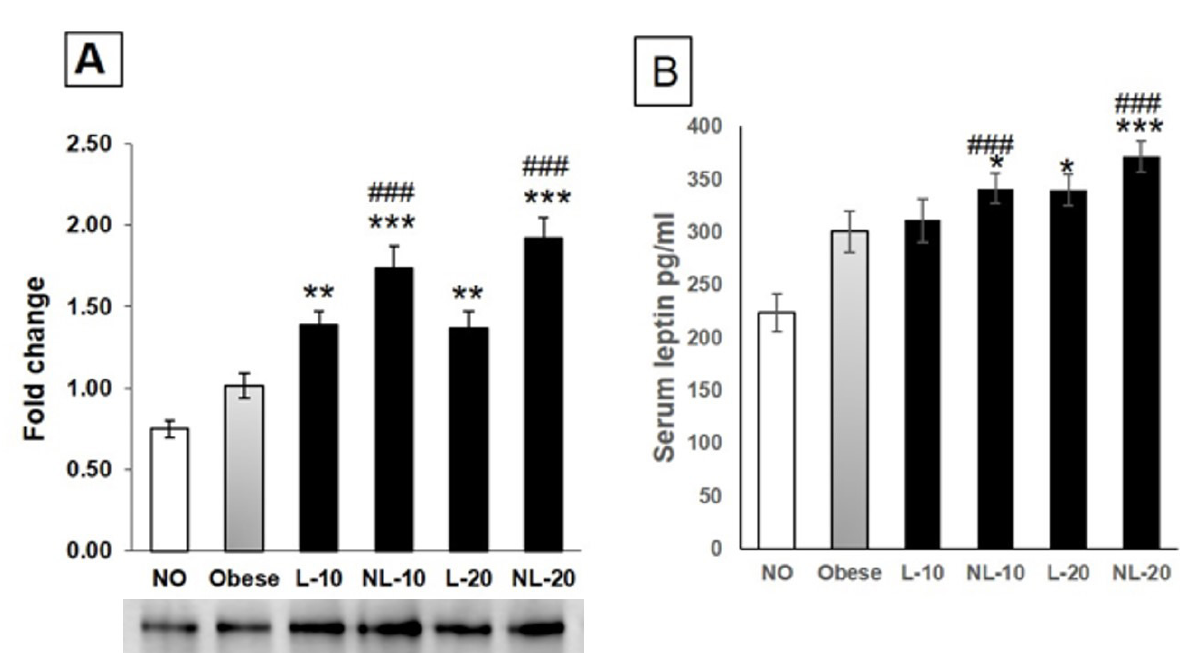
FIGURE 2- Effect of lupine oil on leptin expression: (a) Leptin expression determined by Western blot analysis in the epididymal fat. (b) Serum level of leptin determined by ELISA. NO : non-obese group, Obese : obese untreated group, L-10 and L-20 : crude lupine oil treated groups after 10 and 20 days, NL-10 and NL-20 : Lupine oil nanoemulsion treated groups after 10 and 20 days. Data are represented as means ± SD, ( n = 5). * P < 0.05, ** P < 0.01 and *** P < 0.001 when compared with obese untreated values. # P < 0.05, ## P < 0.01 and ### P < 0.001 when crude oil preparation group is compared to its corresponding